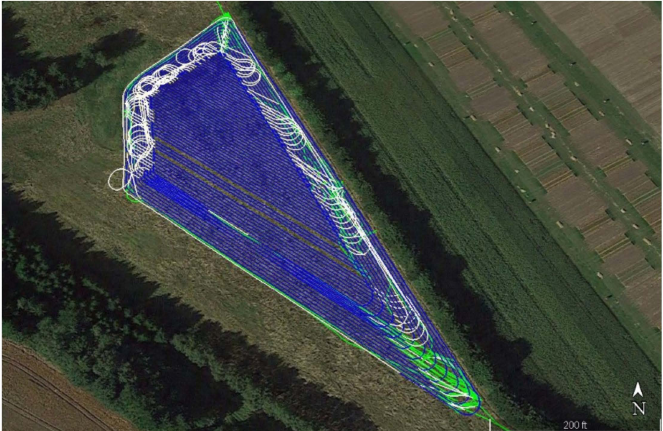
Figure 2. An example of analysis for the robot’s in-field operation. “Manual driving”: When the robot drives manually by the robot’s operator (Green color). “Automatic and working”: When the robot automatically performs the operation in the field (Blue color). “Automatic and not working”: When the robot automatically moves but not performing the operation for example when it turns in the headland part (White